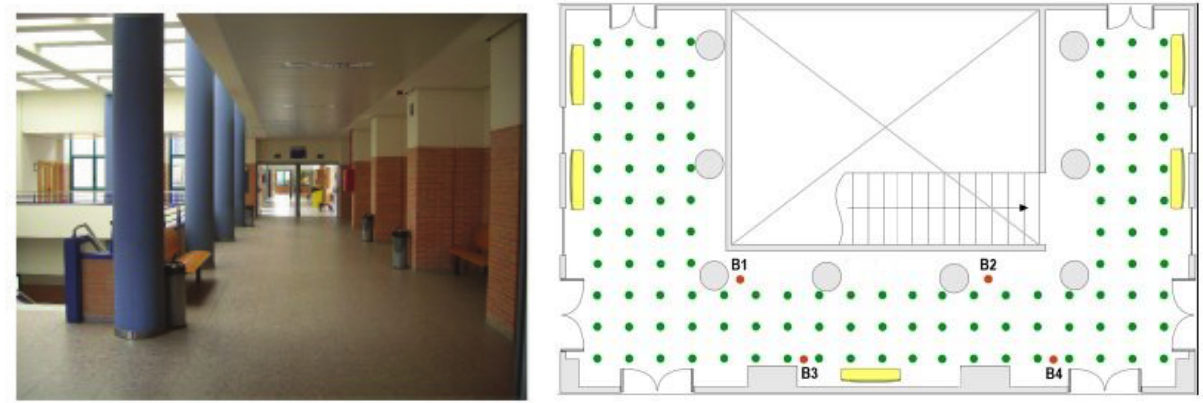
Figure 1. Photo and map of the room where the system was